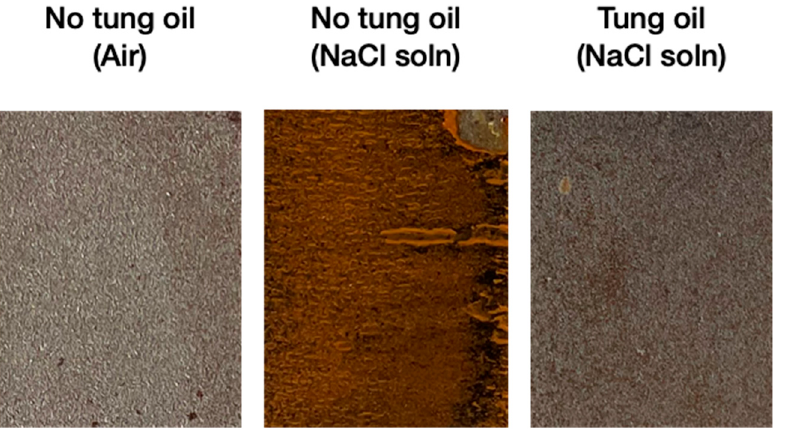
Figure 14. Steel plateswith no tung oil left in air for 24 h, and steel plates with and without tung oil immersed in 3.5 wt. % NaCl solution for 24 h.